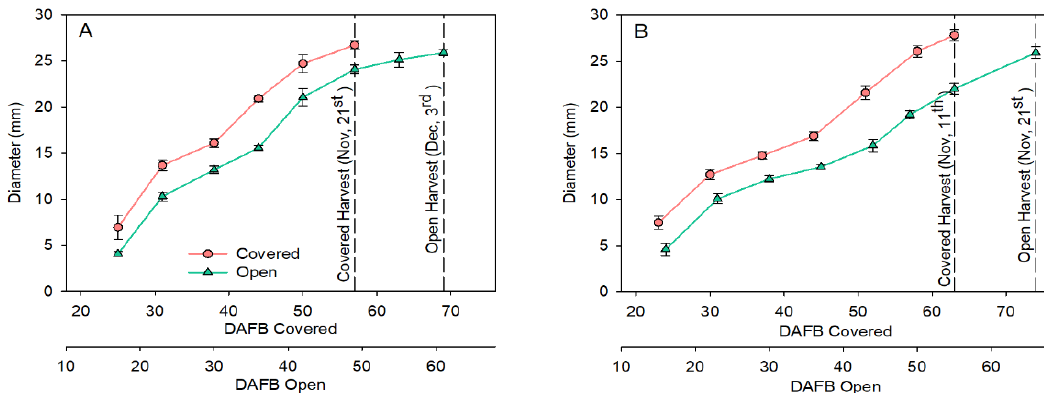
Figure 1. Seasonal patterns of the fruit diameter of ‘Santina’ cherries on ‘Colt’ rootstock from covered and open trees on Plot 1 (( A ) growing season 2018/2019) and on Plot 2 (( B ) growing season 2019/2020). In terms of fruit quality, the high tunnels significantly altered fruit mass, size, and firmness. Fruit from covered trees had higher unitary mass and greater diameter than fruit from trees in the open, but were significantly less firm (Table 2). In Plot 1, fruit from the covered trees averaged 9.1 and 9.7 g for the upper and lower canopies, respectively. In Plot 2, fruit mass from the covered trees averaged 11.0 g for the upper and lower canopies. Fruit from trees under open field conditions, regardless of their position in the tree, had fruit unitary mass values that ranged between 8.6 and 9.2 g. Additionally, fruit from the covered trees was larger than fruit from the trees in the open.